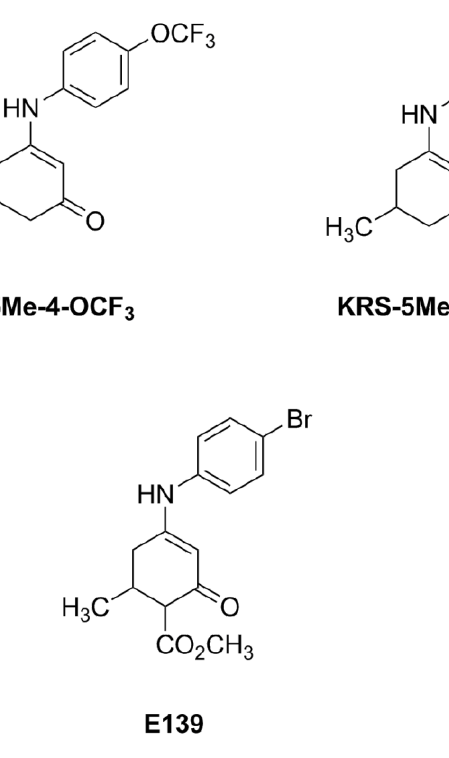
Figure 5. Chemical structure of aniline enaminone analogs. The difference among the three mono methyl compounds is the anilino substitution represented by meta -Chloro; para -Fluoro, and para -trifluoro. E139 is a para -bromo anilino enaminone derivative with a methyl ester substituted moiety at cyclohexenone and Compound 30 is the benzylamino analog. From